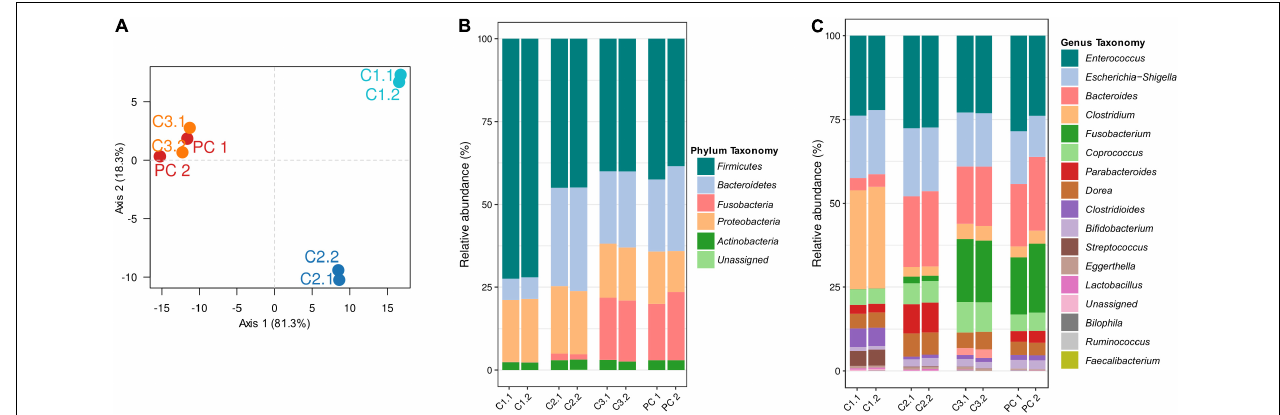
FIGURE 1 | Characterization and evolution of the bacterial community composition of the HGMM. (A) Principal component analysis based on weighted UniFrac β -diversity metric, showing the repartition of the three HGMM subcultures C1, C2, C3 compared to the positive control (PC) resulting to a next 48 h incubation of the HGMM C3 subculture without exposure to molecules (thus equivalent to a C4 subculture). Total variance explained by the two axes was 99.6%. (B) Barplots showing the relative abundances of the HGMM bacterial community through the subcultures at panel (C) phylum level and at panel (C) genus level. Results from two independent replicates analyses (named.1 and.2) are reported for each subculture and for